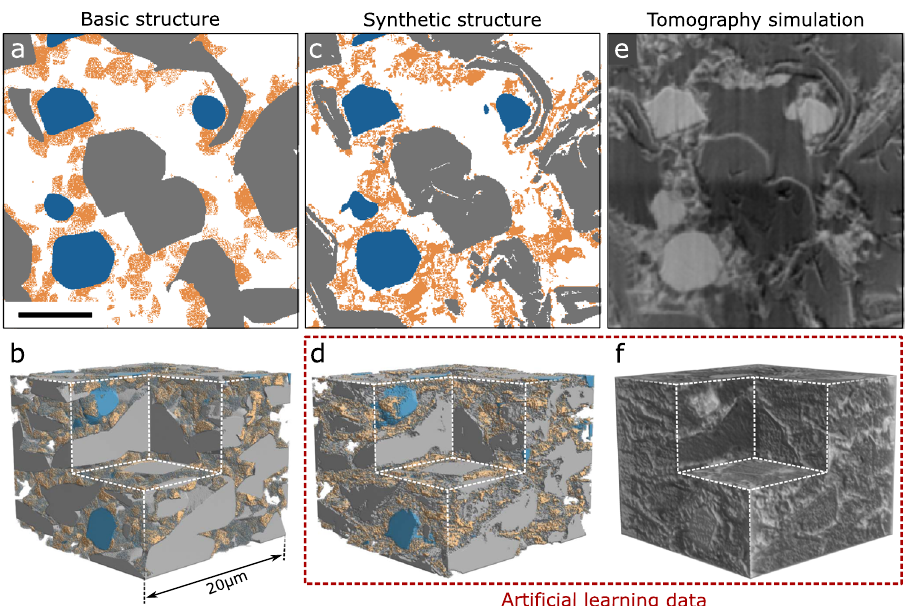
Fig. 5 Generation of arti fi cial learning data. An initial basic structure is generated based on polygon shapes as shown in 2D ( a ) and 3D ( b ). Using a style transfer algorithm, a synthetic structure is achieved ( c , d ). Tomography simulations of the synthetic structure ( f ), the cross-section shown in ( e ), complete the generation of arti fi cial learning data. The scale bar for ( a , c ), and ( e ) is 5 μ